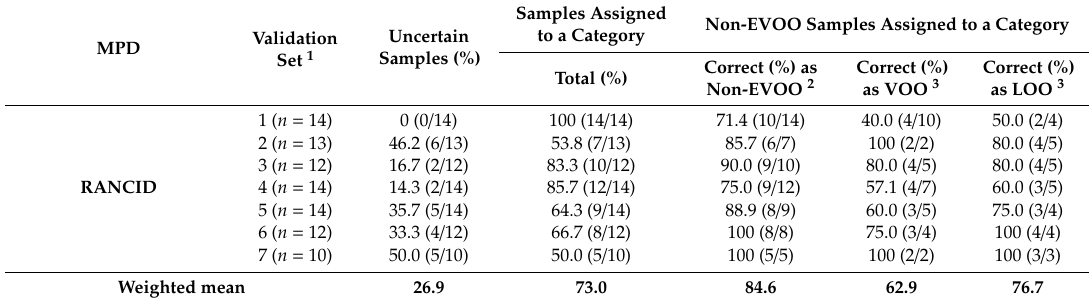
Table 3. External validation classification results for non-EVOO samples ( n = 36), according to the